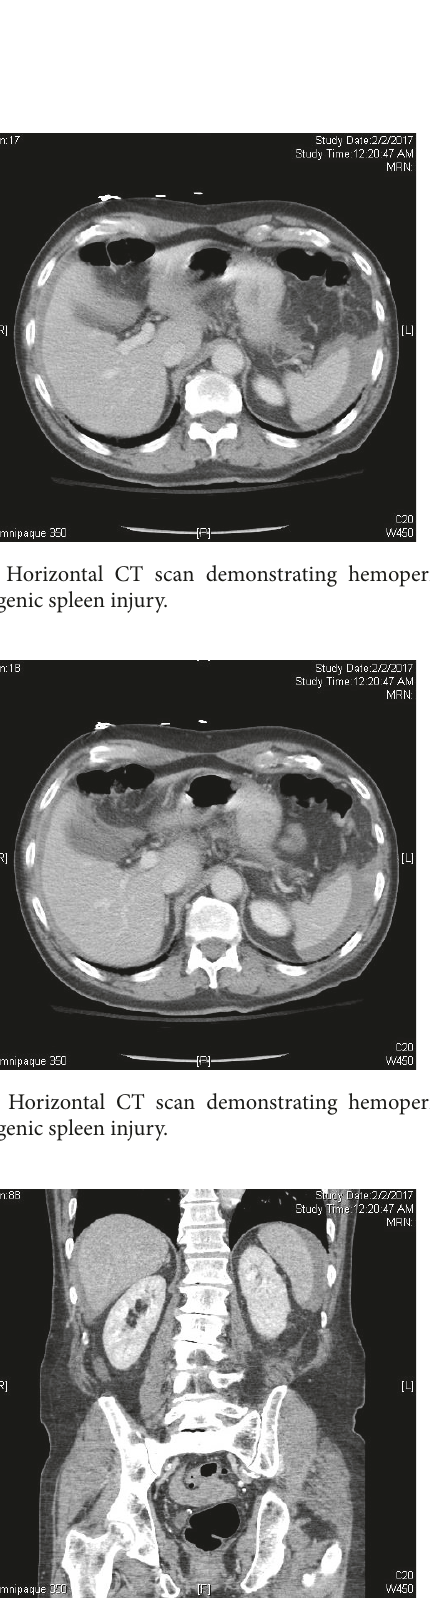
Figure 3: Coronal CT scan demonstrating hemoperitoneum from iatrogenic spleen